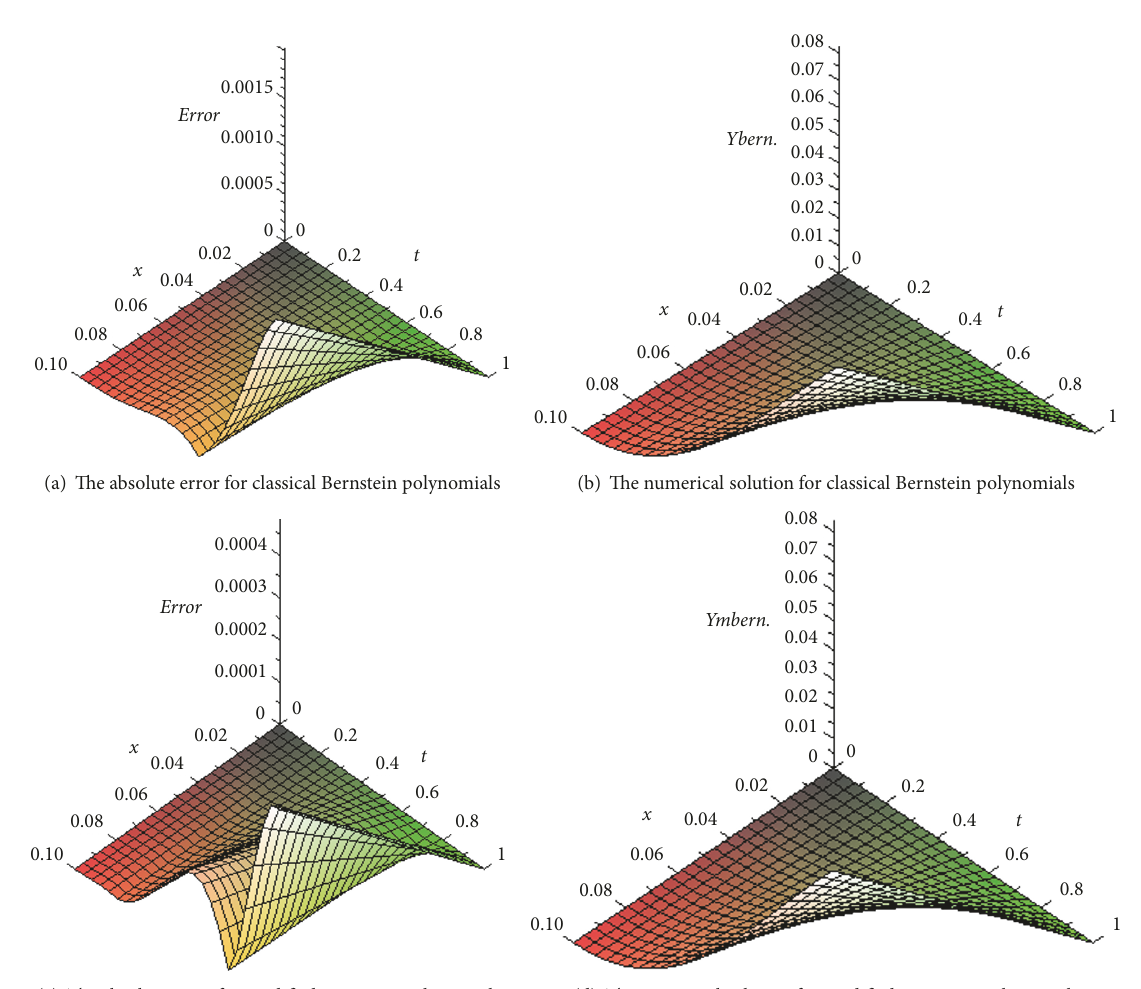
Figure 4: The absolute error between ADM with classical and modified Bernstein polynomials and the exact solution using 𝑦 6 when m=v=6, k=2, and